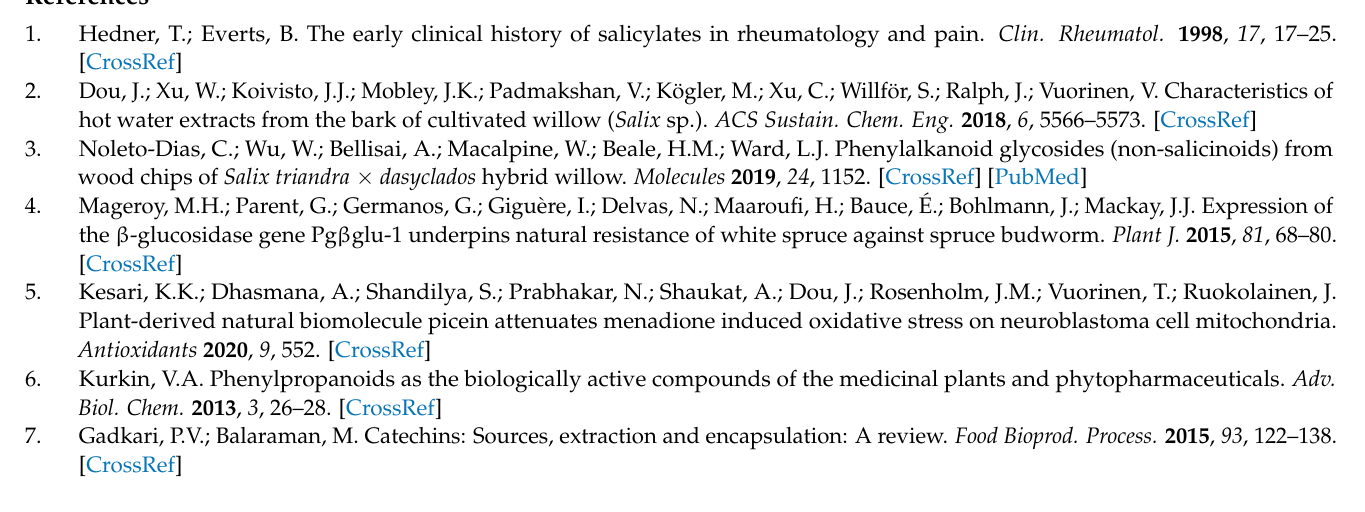
Table S1: The amounts of picein, triandrin, (+)-catechin, fructose, and glucose in willow bark extract presented as